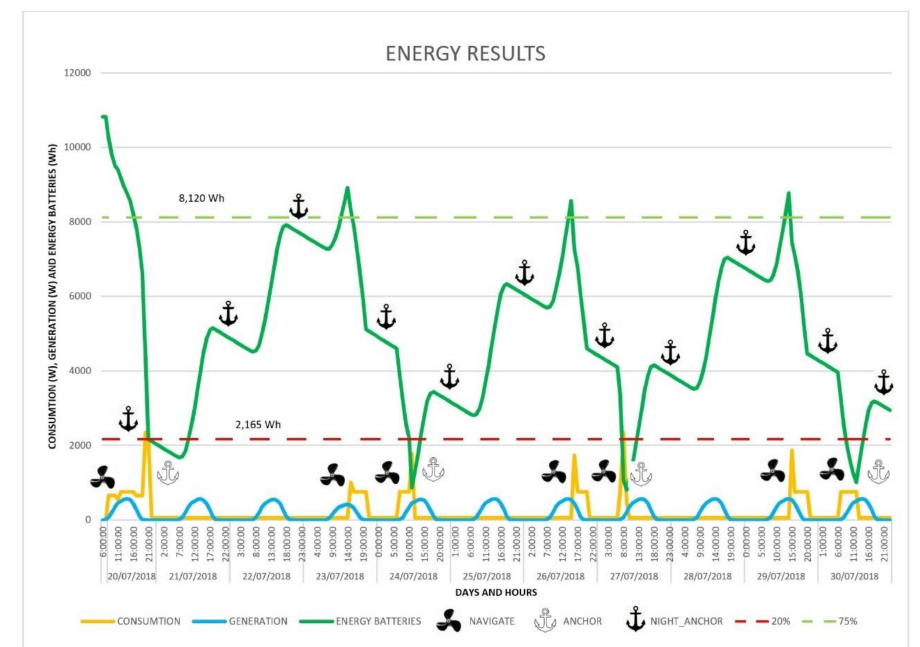
Figure 17. Energy generation and consumption during the 10-day autonomous navigation experiment. ‘Y’ axis has the same scale for all the curves, but the units are different: Watt for orange and blue curves, Watt-hour for green